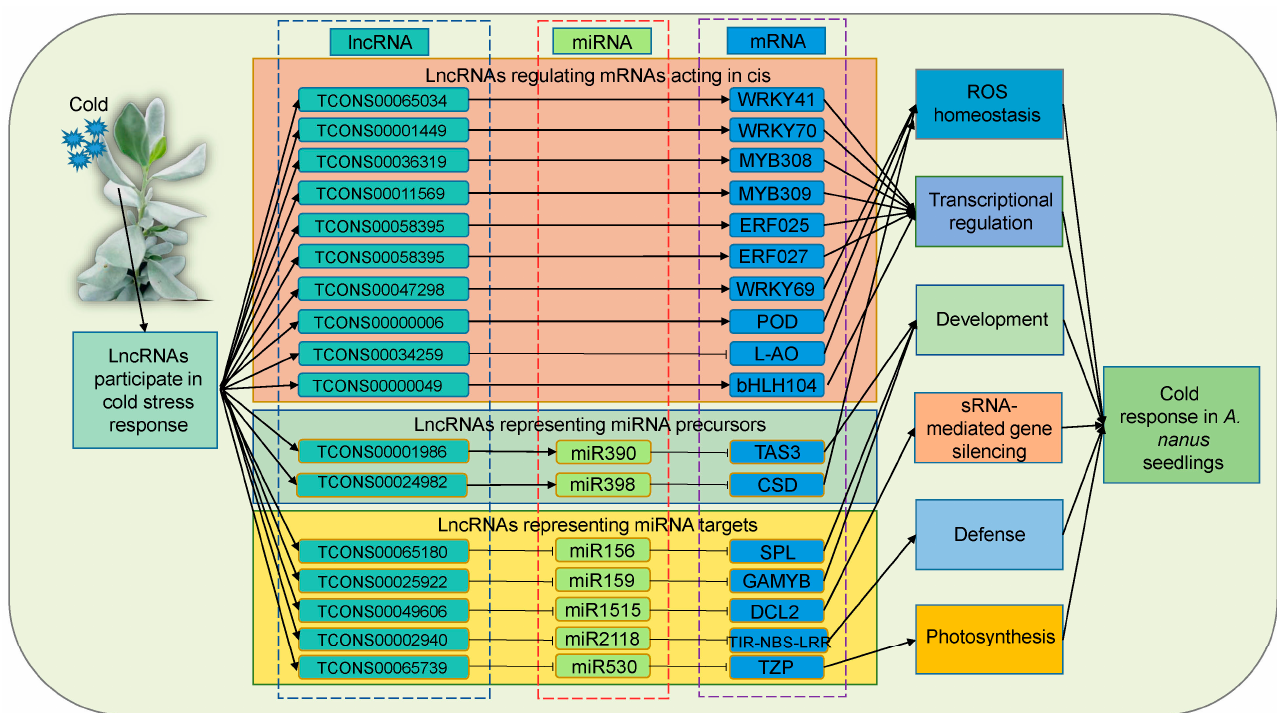
Figure 12. The lncRNA–miRNA–mRNA regulatory network in response to cold in A. nanus leaves. Low-temperature stress leads to high levels of ROS accumulation in plant cells, and high levels of ROS cause severe damage to proteins, membrane lipids, and other cellular components. Plants can activate antioxidant enzymes such as CSD and POD to scavenge excess ROS [51,52]. In the present study, the expression of TCONS00024982 , a precursor of miR398 , was decreased under cold stress, while the expression of miR398 also was decreased. The expression of CSD , a target of miR398 , was increased, and the activity of CSD increased, indicating that TCONS00024982 might down-regulate the expression of miR398 , which in turn enhanced the expression of CSD . The expression of TCONS00000006 , a lncRNA that targets the POD gene, increased under cold stress, while its target, POD , also increased, indicating that TCONS00000006 might up-regulate the expression of POD through cis action. These two lncRNAs might be involved in the cold response in A. nanus by participating in the maintenance of ROS